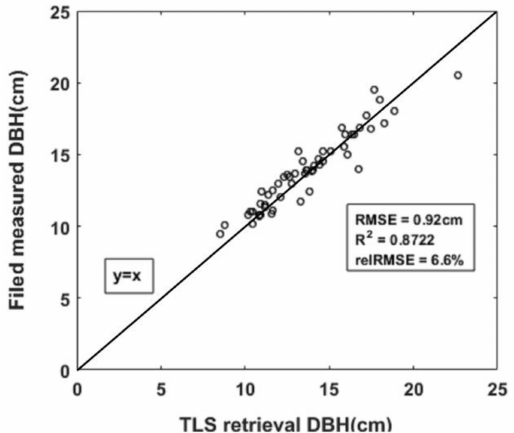
Figure 19. Scatter plot for TLS estimated versus field measured DBH, in the best accuracy condition of single-scan mode of the plantation (nonlinear least square algorithm, a height bin of 0.1 m, and a gray scale threshold of